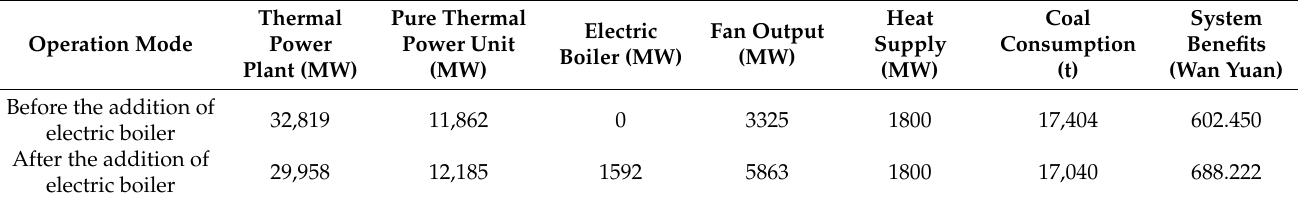
Table 4. Optimization results without or with electric boiler.